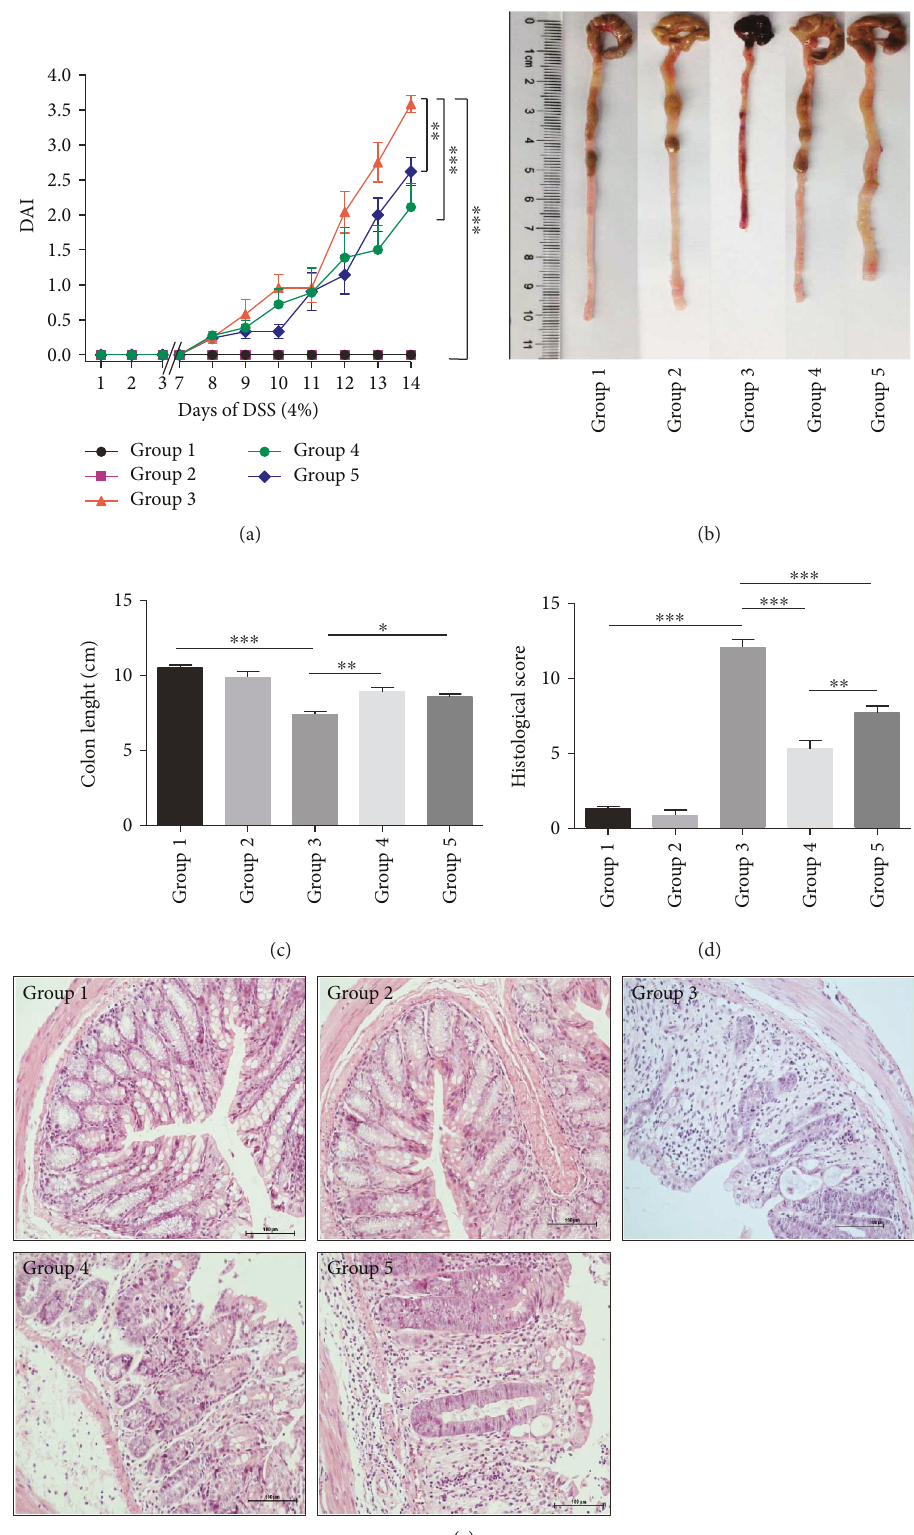
Figure 2: Evaluation of treatment e ffi cacy in colitis mice. (a) DAI was determined in each group of mice. ( n = 8 – 11/group). (b) and (c) Macroscopic observation of the colon. Colon length measured in cm. (d) Histological scores were evaluated in colons. (e) Typical histological images (200x magni fi cation). Data are means ± SEM . ∗ P < 0 05 , ∗∗ P < 0 01 , and ∗∗∗ P < 0 001 . Group 1: normal; group 2: Bi fi co ; group 3: colitis; group 4: pretreated- Bi fi co -colitis; group 5: pretreated +treated- Bi fi co